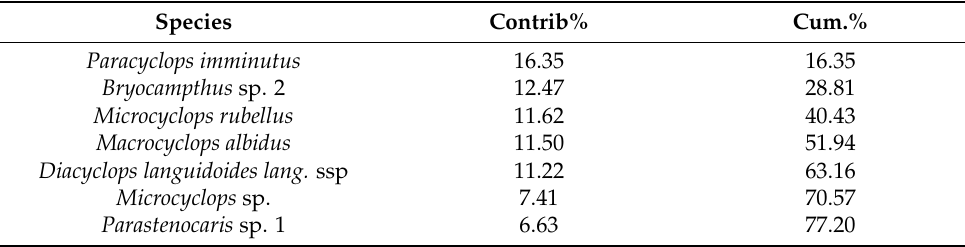
Table 3. SIMPER dissimilarity between the two investigated sites, Heras de Ayuso (Site 1, HEN) (Henares River) and Romanones (Site 2, TAJ) (Tajuna River). Species Contrib% Cum.% Paracyclops